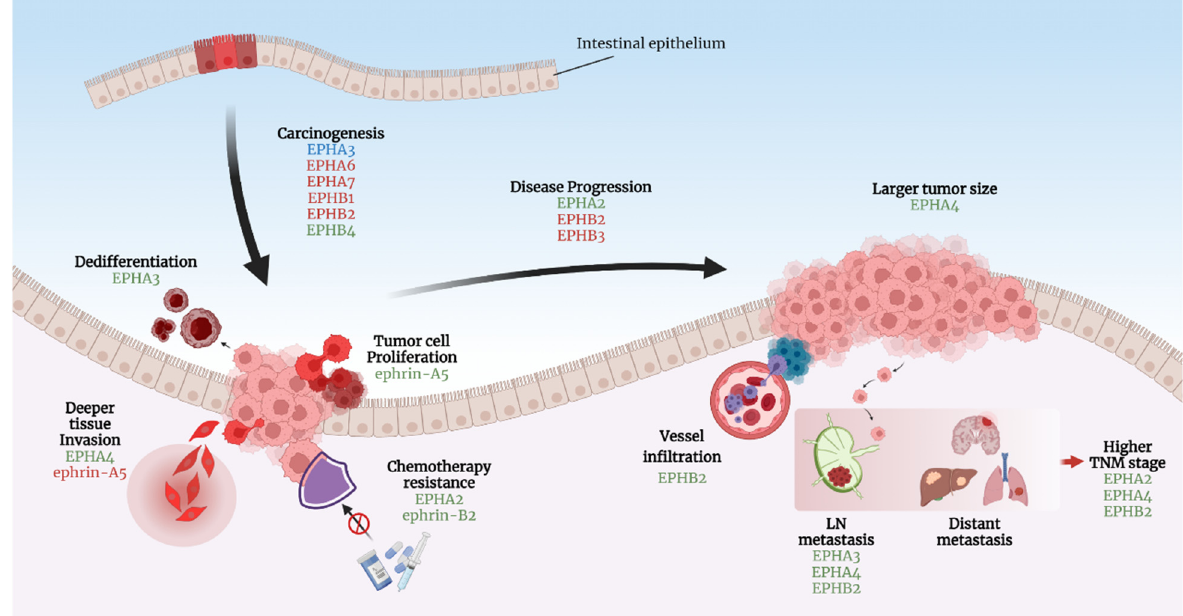
Figure 3. EPHs/ephrins can either enhance or suppress CRC carcinogenesis in various steps. Green fonts: EPHs/ephrins promoting the specific process. Red fonts: EPHs/ephrins inhibit each described action. Blue fonts: Contradictory results have been reported regarding the role of EPHA3 in CRC carcinogenesis. Created with BioRender.com, accessed on 20.2.2022.